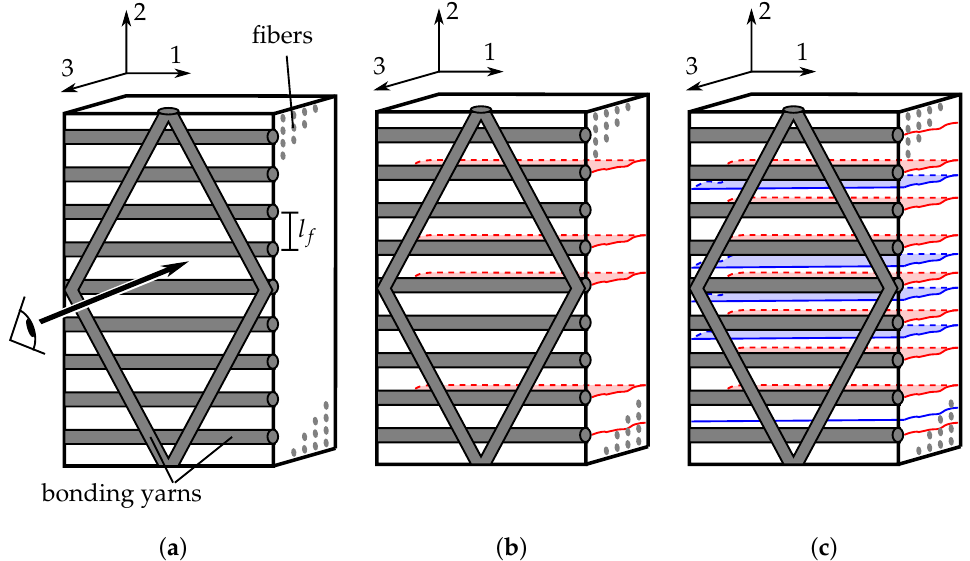
Figure 3. Schematic representation of the cracking process in a single layer of a given laminate: ( a ) the bonding yarns are adhesively attached on top of the UD-ply ( l f = 5mm), ( b ) first crack initiation (red) covered by bonding yarns, and ( c ) subsequent initiation of additional cracks (blue) in the latter course of the experiment growing between bonding yarns, which are clearly visible. The direction of observation is parallel to the 3-direction.